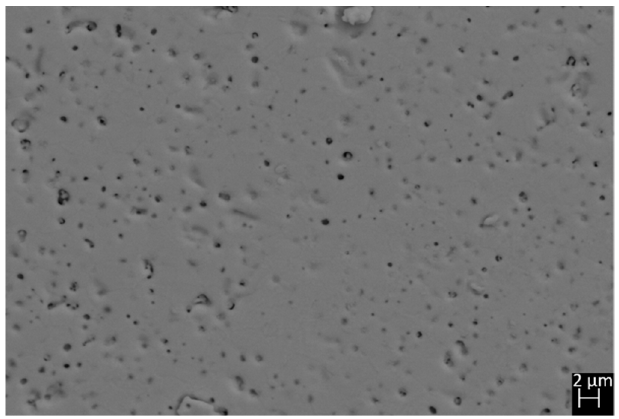
Figure 2. Microphotograph taken by backscattered electrons on the polished surface of sample Sm40.